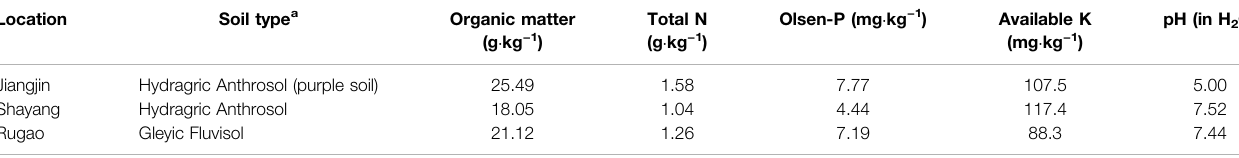
TABLE 1 | Average soil properties at the experimental sites at the beginning of the experiment. Location